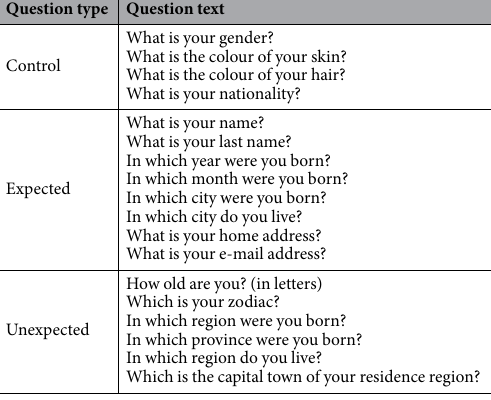
Table 1. List of the 18 questions presented to participants divided by type (control, expected and unexpected